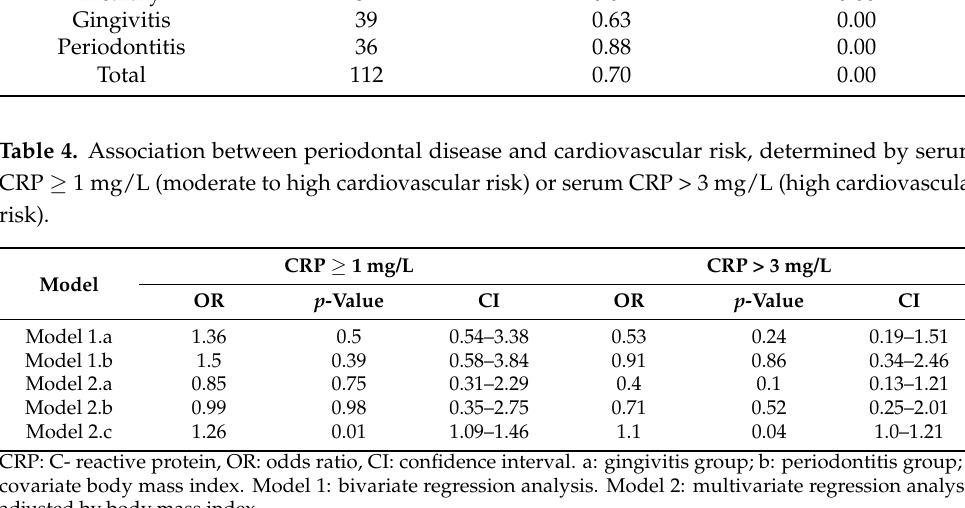
Table 3. C-reactive protein correlations between serum and gingival crevicular fluid. Group